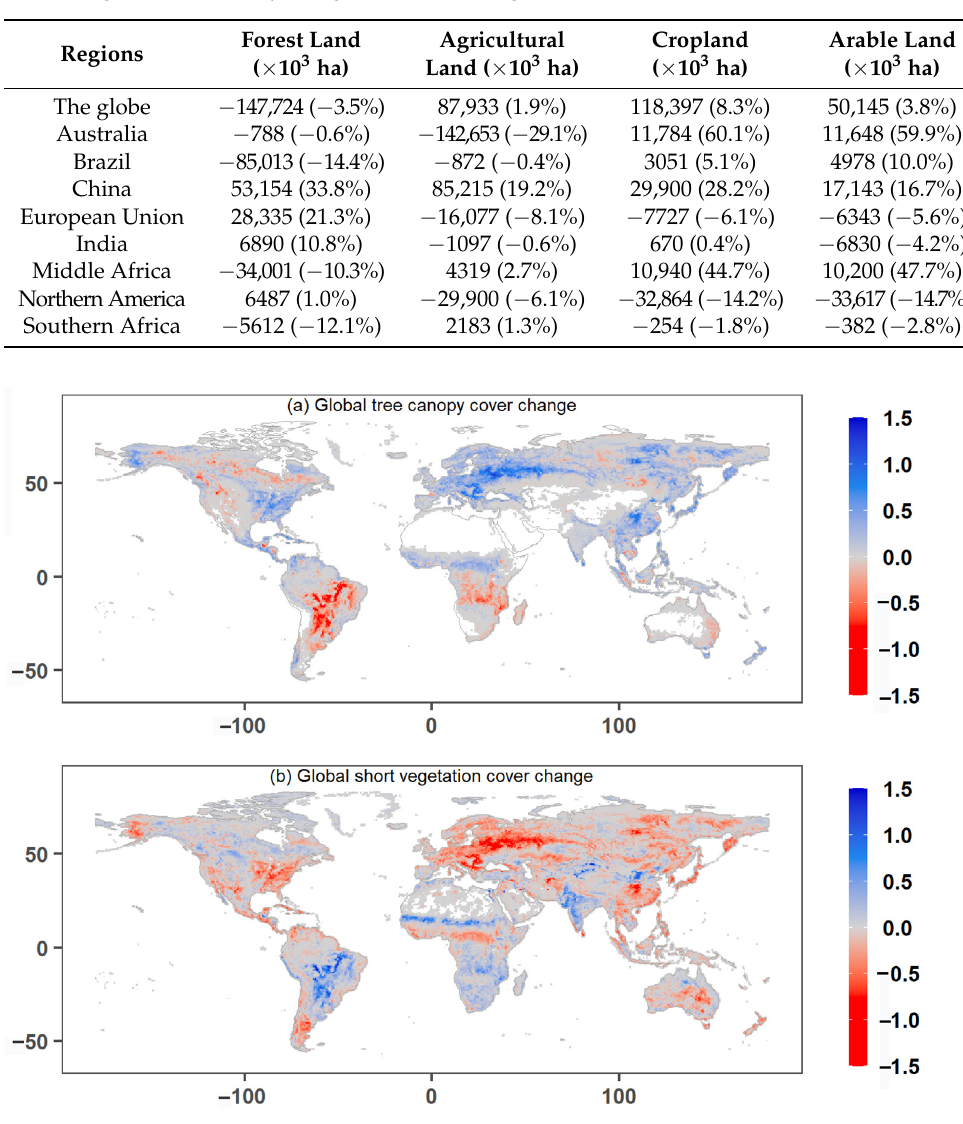
Figure 9. The trends in global land cover change for ( a ) tree canopy (TC), ( b ) short vegetation (SV), and ( c ) bare ground (BG) during 1982–2015. Further highlighting the role of LU necessitates intercomparison between the pro- portion of areas with significant decrease, decrease, increase, and significant increase in different land cover types for the regions showing significant positive and negative im- pacts of LU on vegetation change (Figure 10). By increasing/decreasing the TC/BG cover, Positive LU (afforestation, irrigation, forestry, etc.) significantly affects the vegetation pat- terns. Specifically, for the regions with significant positive impacts of LU on vegetation change, 32.5% of regions show significant increasing trends of TC cover, while only 6.8% have significant growing trends of BG cover (Figure 10d–f). In contrast, we noticed that 13.5% of regions of BG cover show significant increasing trends when LU has significant negative impacts on regional vegetation change (Figure 10a–c).